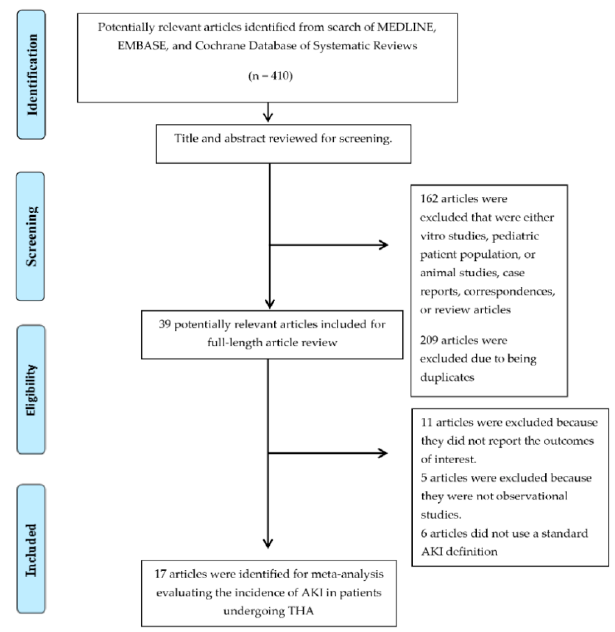
Figure 1. Outline of our search methodology. 119